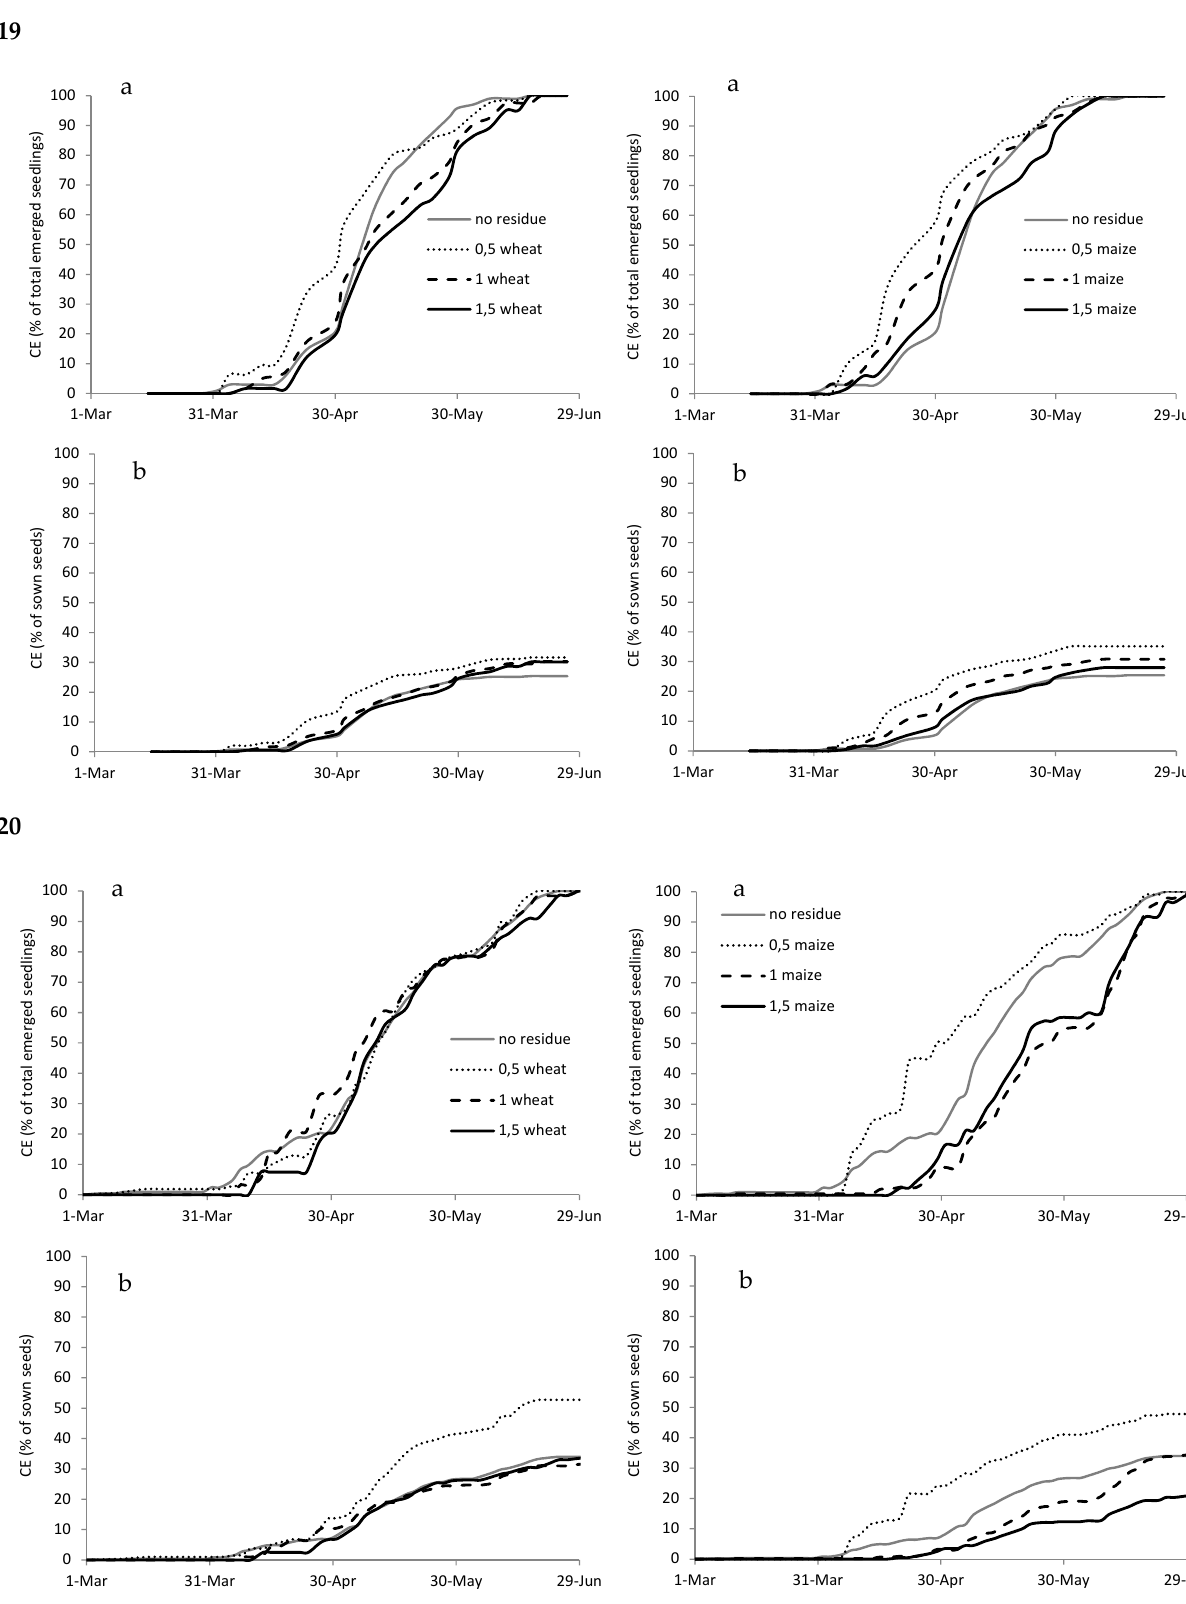
Figure A7. Cumulated emergence (CE) expressed as percentage of total emerged seedlings ( a ) and as percentage of sown seeds ( b ) of Sonchus oleraceus in 2019 and 2020 with different types (wheat on the left and maize on the right) and amounts of crop residues.